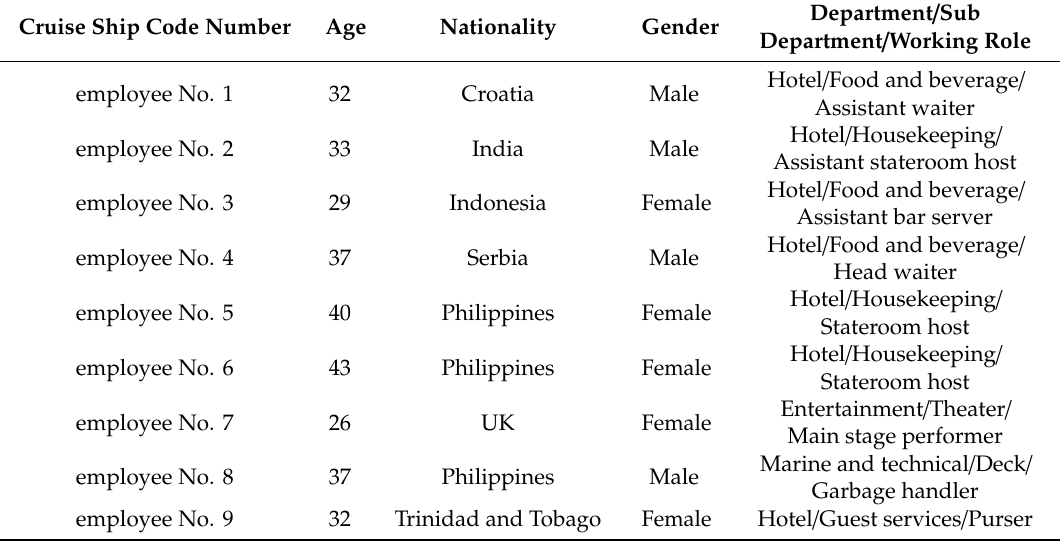
Table 1. Demographic profile of